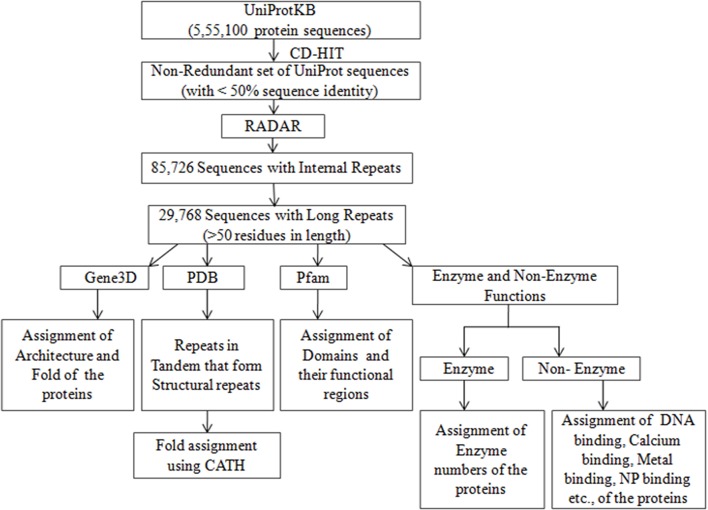
Flow diagram of identification and analysis of Long repeats from non-redundant set of UniProt sequences.